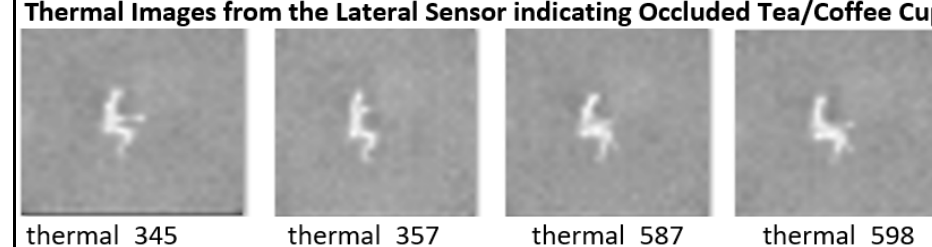
Figure 6. Thermal images from the lateral sensor indicating instances of occluded tea/coffee cups that are visible on the ceiling sensor. Refer to the thermal blobs with the same name as thermal_345, thermal_357, thermal_587, and thermal_598 in Figure 7.